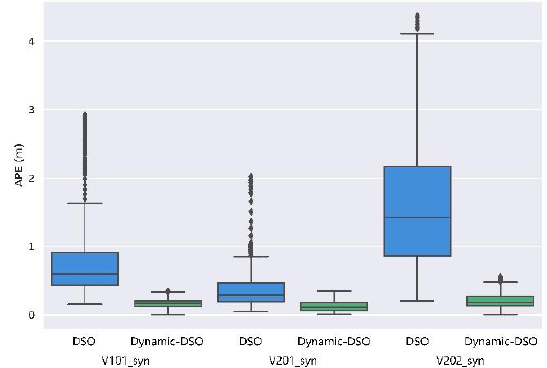
Figure 14. Boxplot of the trajectory error between Dynamic-DSO and DSO in V101_syn, V201_syn and V202_syn.